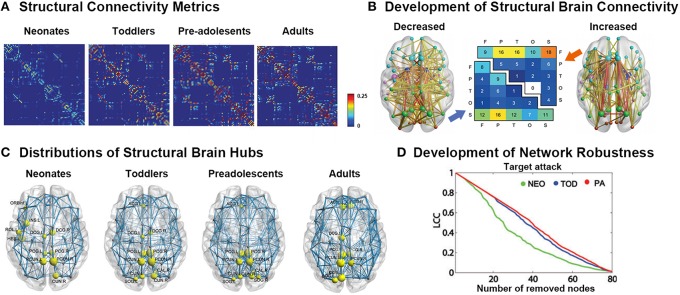
Development of white-matter connectomes. (A) Structural connectivity matrices of the neonates, toddlers, pre-adolescents, and adults group-averaged connectome. Adapted from Huang et al. (2015). (B) Late adolescent developmental changes in structural connectivity, with the thickness of each connection weighted by its associated one-tailed t-test statistic (FWE corrected, p < 0.05). Edge color represents connection type: non-hub to non-hub (yellow), hub to non-hub (orange), and hub to hub (red), with larger nodes corresponding to hub regions. Node color represents the assignment of each region of interest to one of five broad anatomical divisions: frontal (cyan), parietal (lime), temporal (magenta), occipital (orange-red), or subcortical (blue). The center panel illustrates the anatomical distribution of developmental decreases (lower triangular matrix) and increases (upper triangular matrix) in connectivity based on the classification of edges according to the anatomical divisions they interconnected. The values in these matrices represent relative proportions, calculated as the ratio between the frequency of edges linking each pair of divisions and the total number of edges belonging to the two categories. Adapted from Baker et al. (2015). (C) Distributions of hub regions in different age groups based on nodal efficiency centrality. PCG, precentral gyrus; PCUN, precuneus; CUN, cuneus; DCG, dorsal cingulate gyrus; INS, insular; ACG, anterior cingulate gyrus; SOG, superior occipital gyrus; ORBinf, inferior frontal gyrus; ROL, rolandic operculum; HES, Heschl's gyrus. Adapted from Huang et al. (2015). (D) Topological robustness of the structural networks in each group. The graphs show the AUC of the largest connected component (LCC) as a function of the removed node number by targeted attacks. The brain networks in the preadolescents (red line) were approximately as robust as those in toddlers (blue line) in response to both target failures. However, the neonates (green line) displayed remarkably reduced stability against both targeted attack and random failure compared with the other two groups. Adapted from Huang et al. (2015).